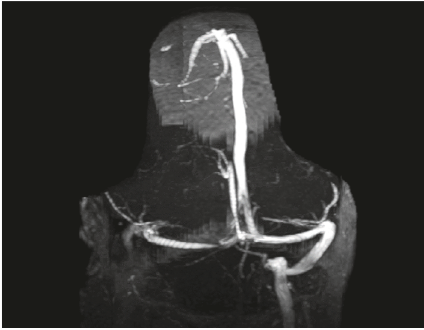
Figure 5: Sagittal reformatted postcontrast FSPGR images demon- strating filling defect within the left sigmoid sinus and a clearer view of the jugular vein. Arrow demonstrates thrombus within the distal sigmoid sinus and internal jugular vein.